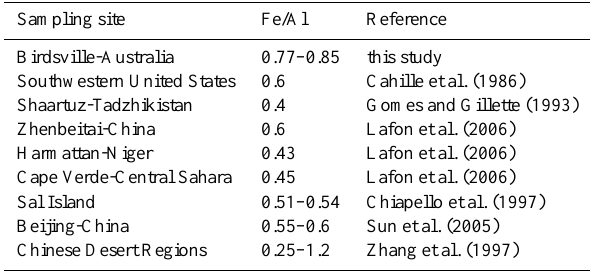
Table 5. Ratios of Fe to Al. Sampling